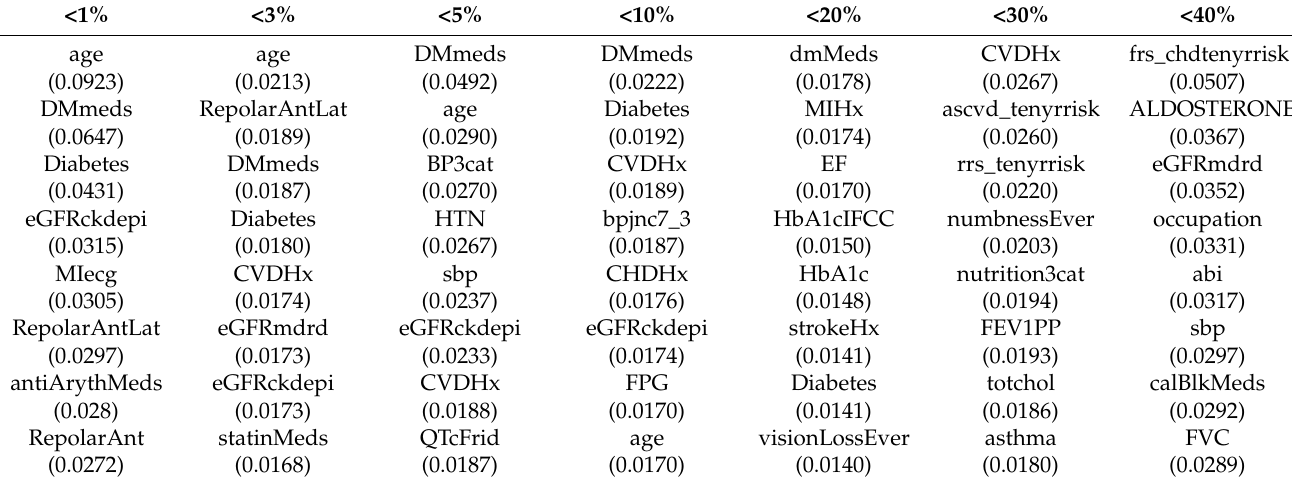
Table 2. The selected parameters of the final HF prediction model for XGBoost using complete cases (feature importance is in the